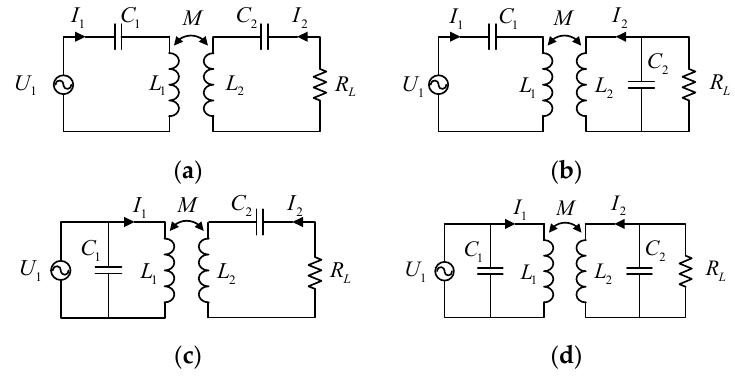
Figure 1. Four compensation modes. ( a ) series-series (SS) compensation; ( b ) series-parallel (SP) compensation; ( c ) parallel-series (PS) compensation; ( d ) parallel-parallel (PP) compensation.